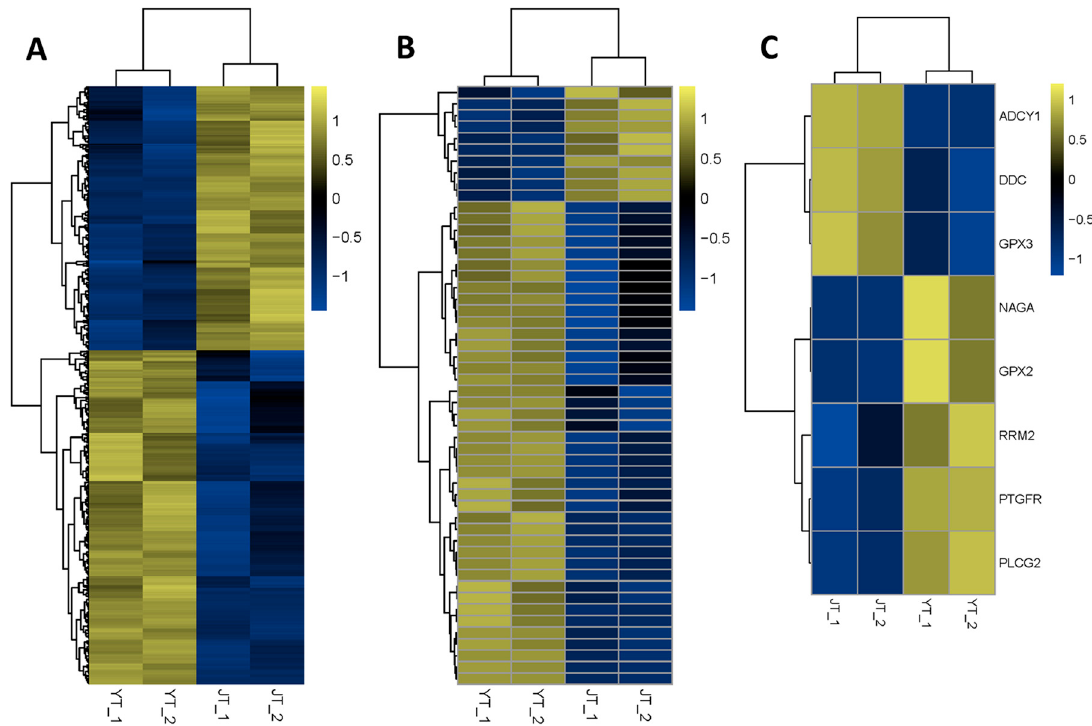
Figure 2. Heat maps of the distinguishable expression profiles in the thyroid gland of Jinhua and Yorkshire pig breeds. ( A ) Hierarchical clustering of the differentially ‐ expressed mRNAs; ( B ) Differentially ‐ expressed lncRNA transcripts; and ( C ) TH ‐ regulation ‐ related genes is performed. Yellow indicates relatively high expression and blue denotes relatively low expression.